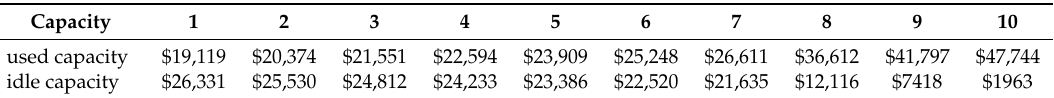
Figure 5. Comparison between traditional (absorption) and TDABC costing.